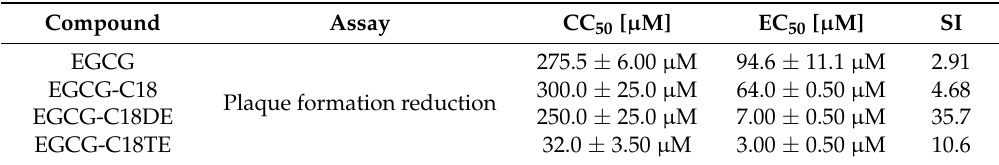
Table 6. Cytotoxicity and Protective Effect of EGCG and EGCG-Fatty Acid Derivatives against Influenza A/PR/8/34(H1N1)